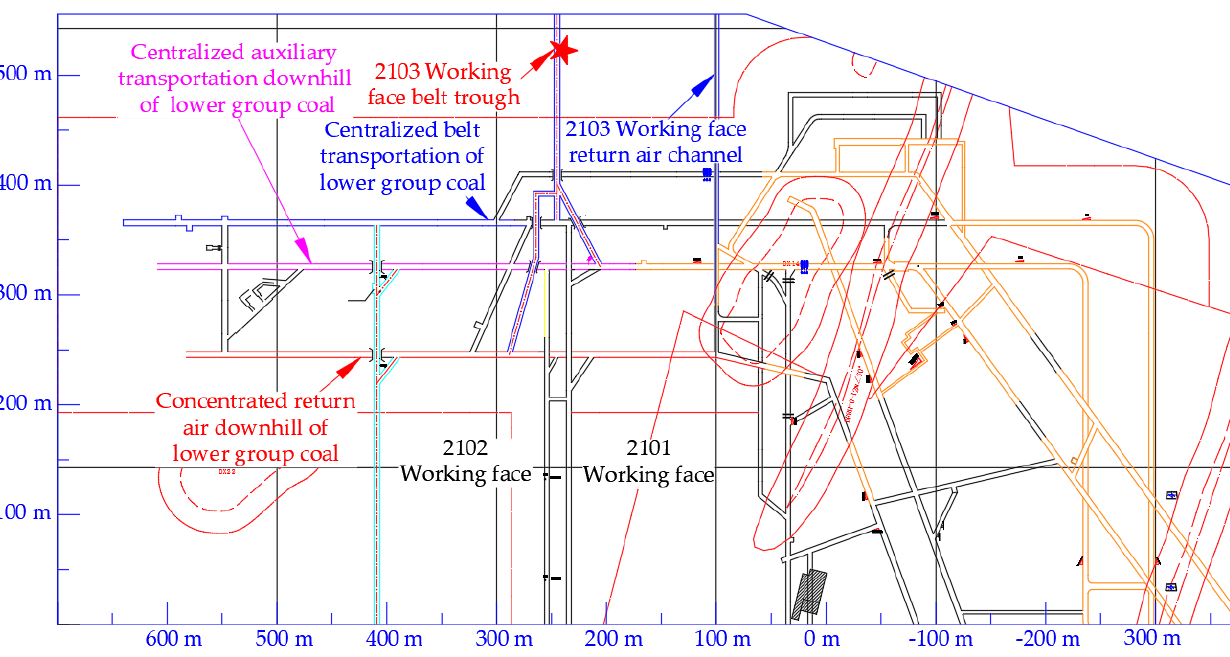
Figure 3. Hollow—inclusion stress gauge.